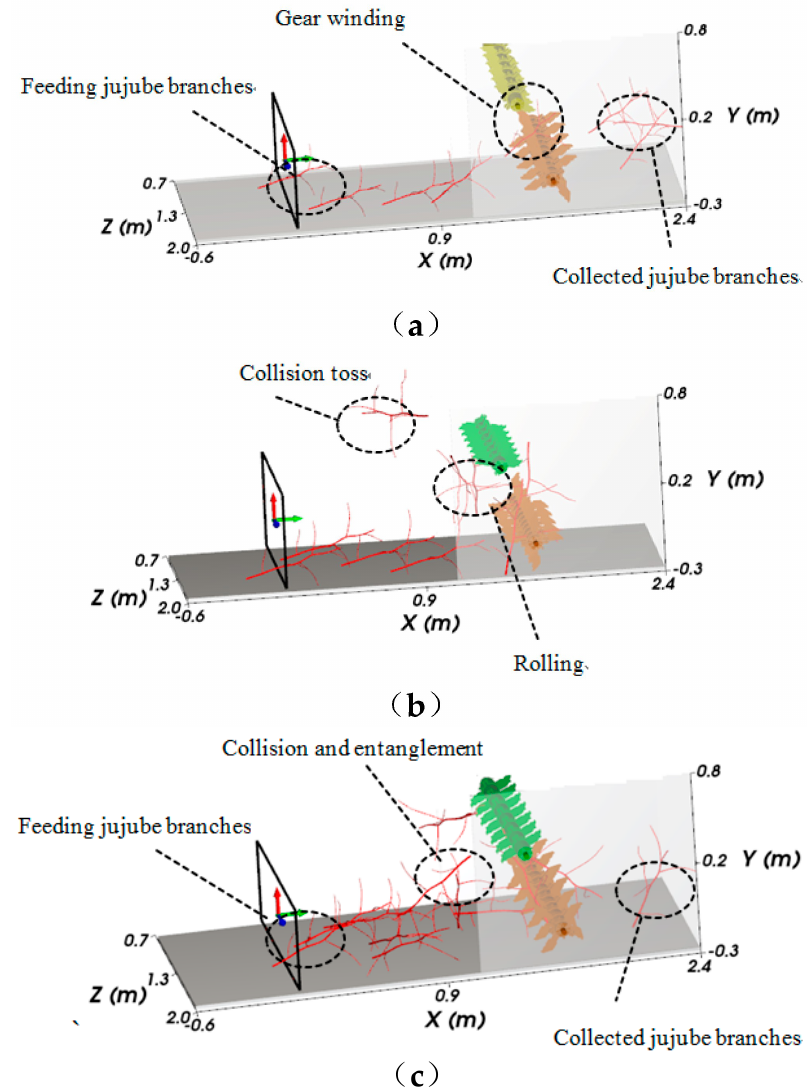
Figure 5. Movement behavior analysis of jujube branches in the picking mechanism. ( a ) State of jujube branches with a size of 480 mm when the time point is 10.65 s. ( b ) State of jujube branches with a size of 640 mm when the time point is 12.9 s. ( c ) Collection state of jujube branches with a size of 800 mm when the time point is 13.65 s.